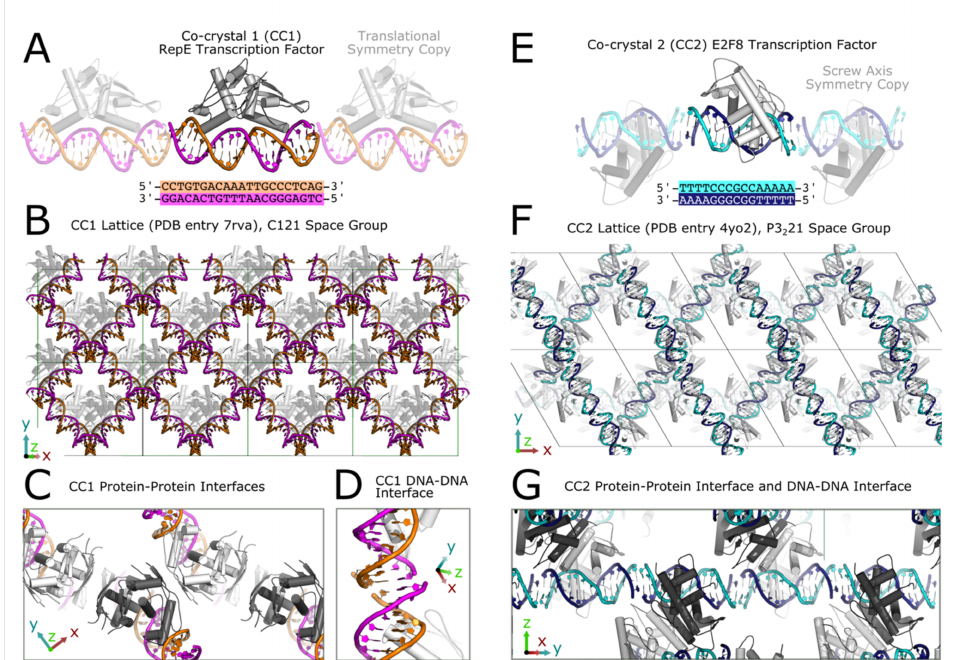
Figure 2. ( A ) The building block for co-crystal 1 (CC1) consists of the RepE54 transcription factor bound to 21-mer cognate DNA (represented here by PDB entry 1rep). (B ) A collection of neighboring CC1 unit cells oriented to show the DNA stacks in 2 dimensions, with protein at 50% transparency. ( C ) The CC1 lattice has C121 symmetry, and all DNA–DNA junctions are symmetry equivalent to ( D ) the single DNA–DNA junction shown here. ( E ) The building block for co-crystal 2 (CC2) consists of the E2F8 transcription factor bound to 15-mer cognate DNA (represented here by PDB entry 4yo2). ( F ) A collection of neighboring CC2 unit cells oriented to show the DNA stacks in two dimensions, with protein at 50% transparency. ( G ) The CC2 lattice has P3 2 21 symmetry, and all DNA–DNA junctions are symmetry equivalent to the single DNA–DNA junction shown here. Images were generated in PyMOL.